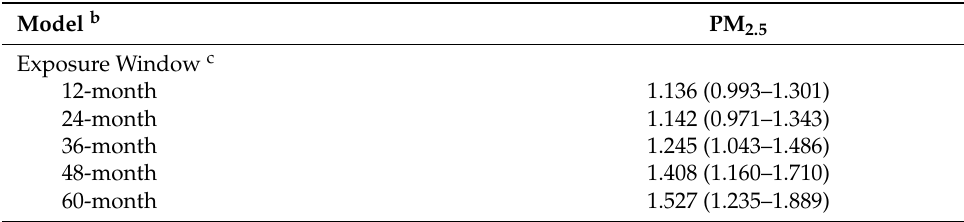
Table 2. Type 1 diabetes mortality hazard ratios (95% CI) associated with a 10 µ g/m 3 increase in 12- to 60-month moving average PM 2.5 , US 2000–2008.